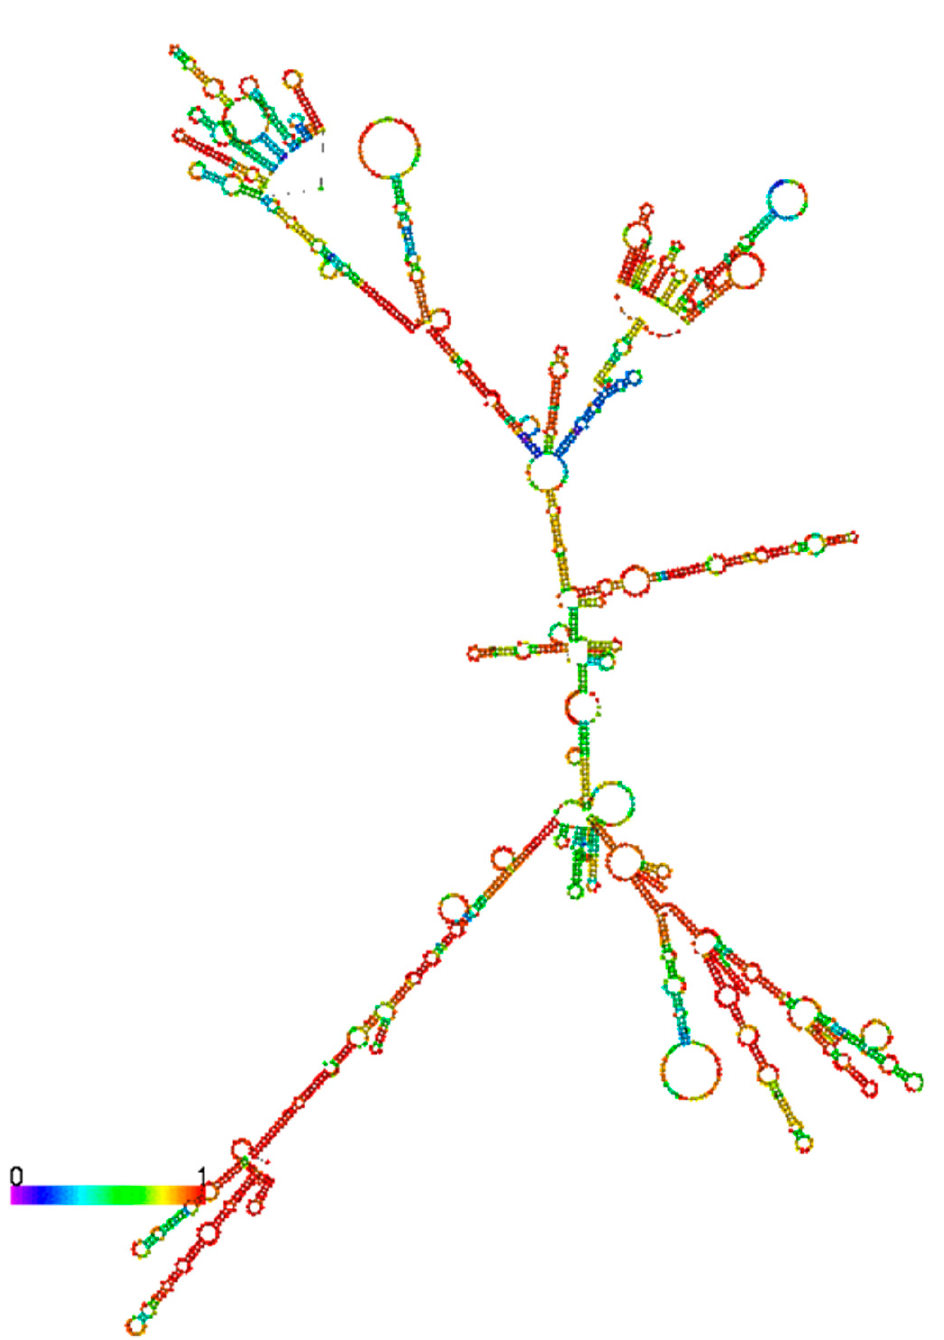
Figure 5. Predication of secondary structure of HNF1 α -AS1 by RNAfold. The structure of HNF1 α -AS1 is generated based on minimum free energy method. The colors indicate base-pair probabilities from low to high.